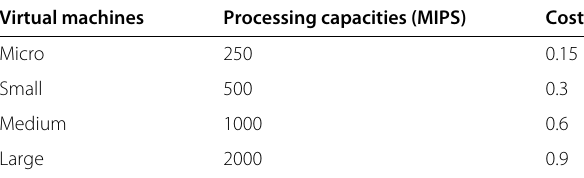
Table 3 VM types and pricing